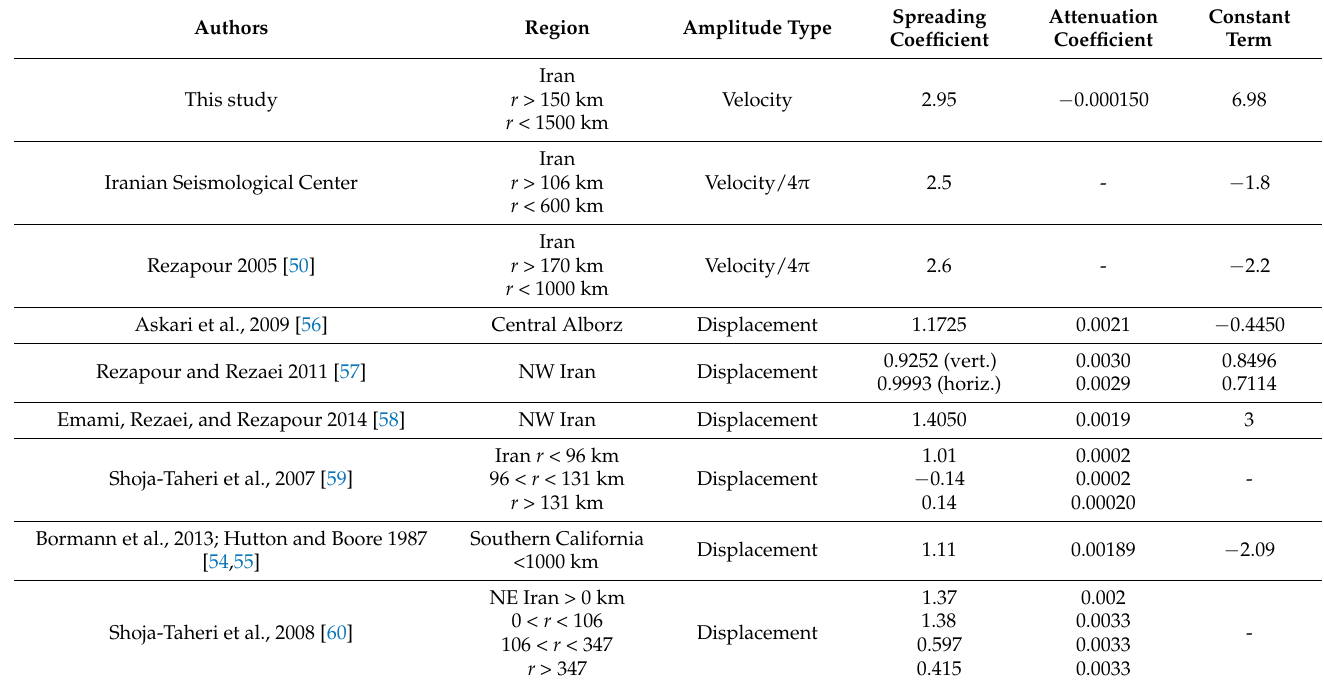
Table 1. Regional magnitude relationships. Velocity refers to the maximum vertical velocity output of the SS-1 seismometer; displacement refers to the maximum displacement on horizontal Wood- Anderson